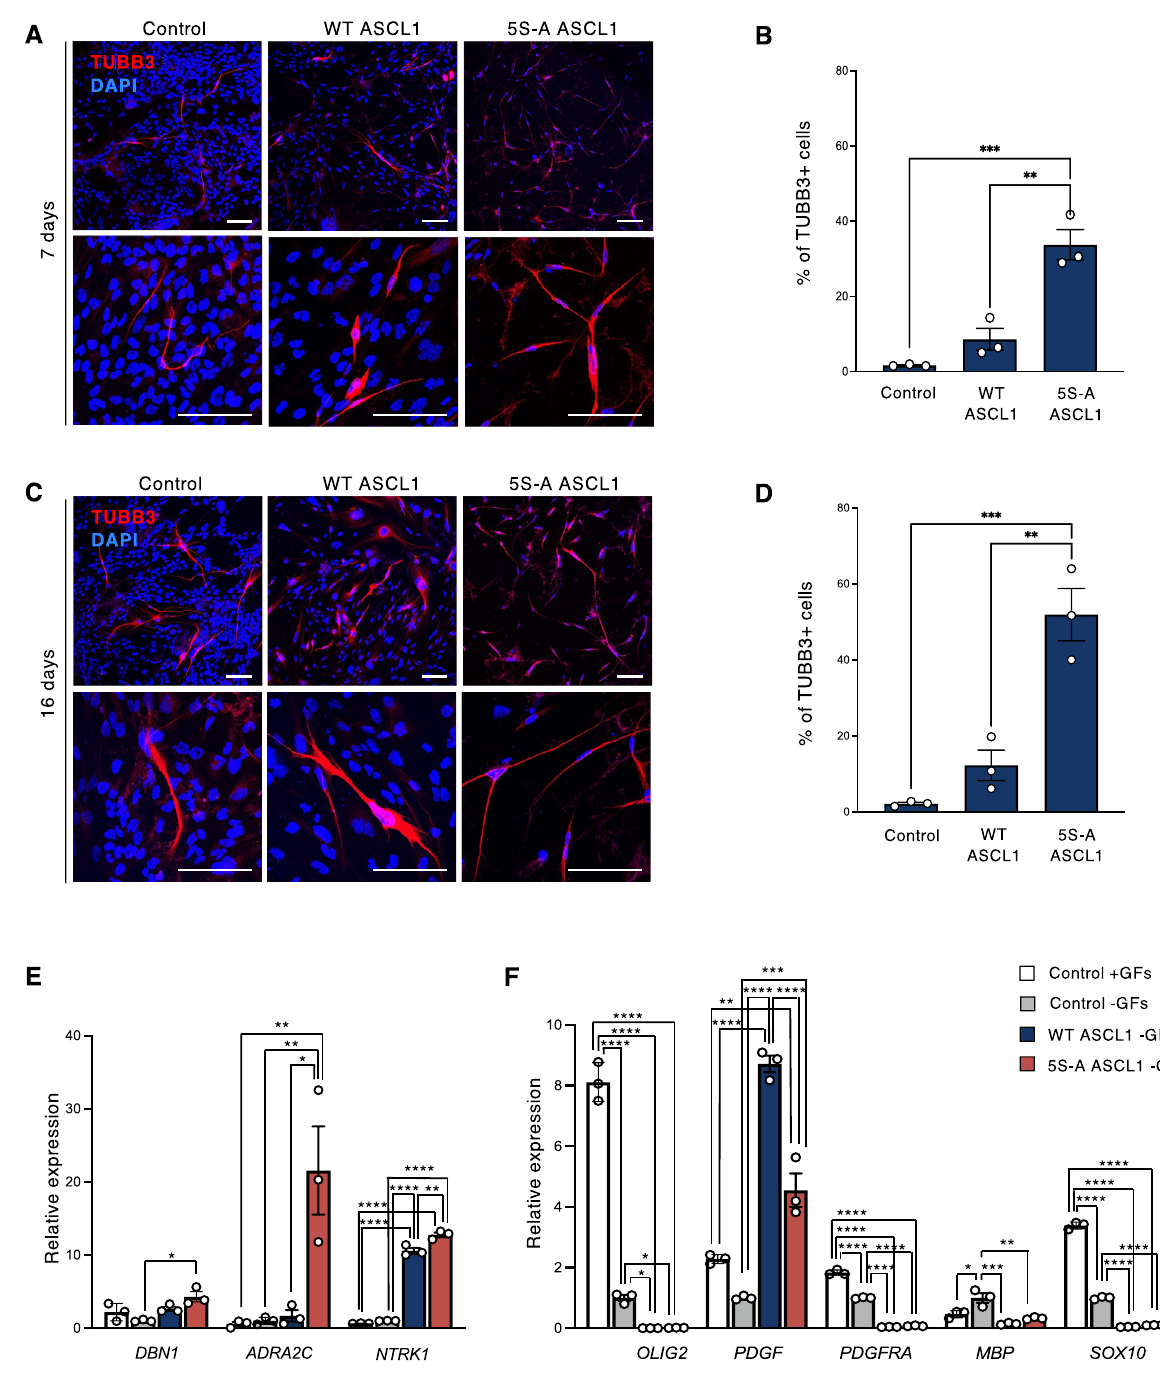
Figure 2. Dephosphorylated ASCL1 promotes neuronal differentiation. ( A – C ) Immunostaining for the neuronal marker TUBB3 (red) and quantification of the % of TUBB3 + cells over the total DAPI + cells cultured for 7 ( A , B ) or 16 days ( C , D ) without growth factors and in the presence of dox to induce ASCL1 expression. Scale bars: 100 μm. Data: mean ± SEM n = 3 independent experiments; one-way ANOVA followed by the Bonferroni post-hoc test; ** p < 0.01; *** p < 0.001. ( E , F ) Relative mRNA expression of different neuronal ( E ) and oligodendrocyte ( F ) markers at 7 days. Data: mean ± SEM, normalized to TBP . n = 3 independent experiments; one-way ANOVA followed by the Bonferroni post-hoc test; * p < 0.05; ** p < 0.01; *** p < 0.001; **** p <